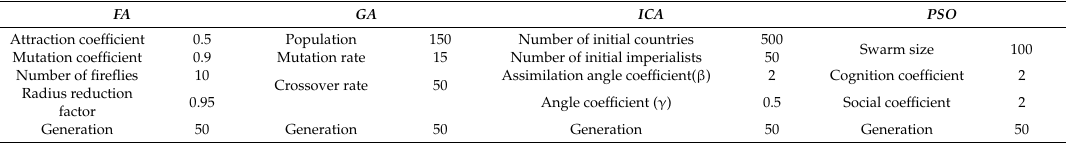
Figure 10 indicates the comparison of experimental and computational values for the creep strain parameter using the ANN model modified by the FA, ICA, GA and PSO. The results presented indicated that the ANN model optimized by the FA determined the creep strain values more accurately than other algorithms. This has been stated on the basis of the comparison of the values of linear correlation coefficient R , mean absolute error MAE , mean squared error MSE and root mean square error RMSE .